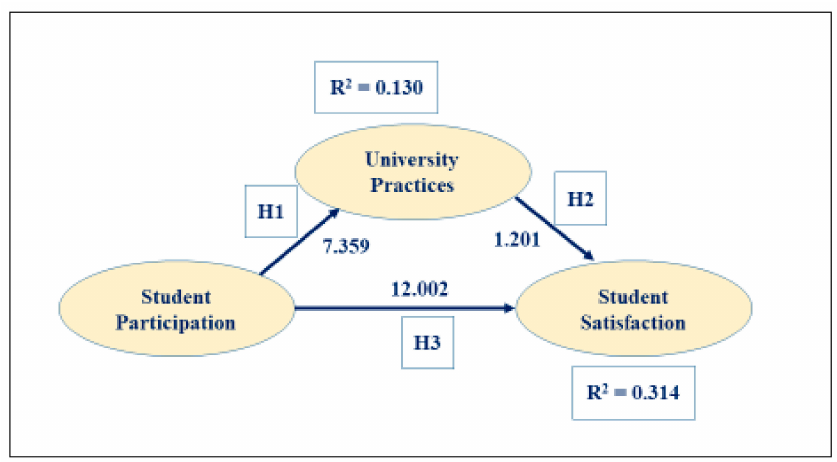
Figure 3. Results of the structural model. Source: